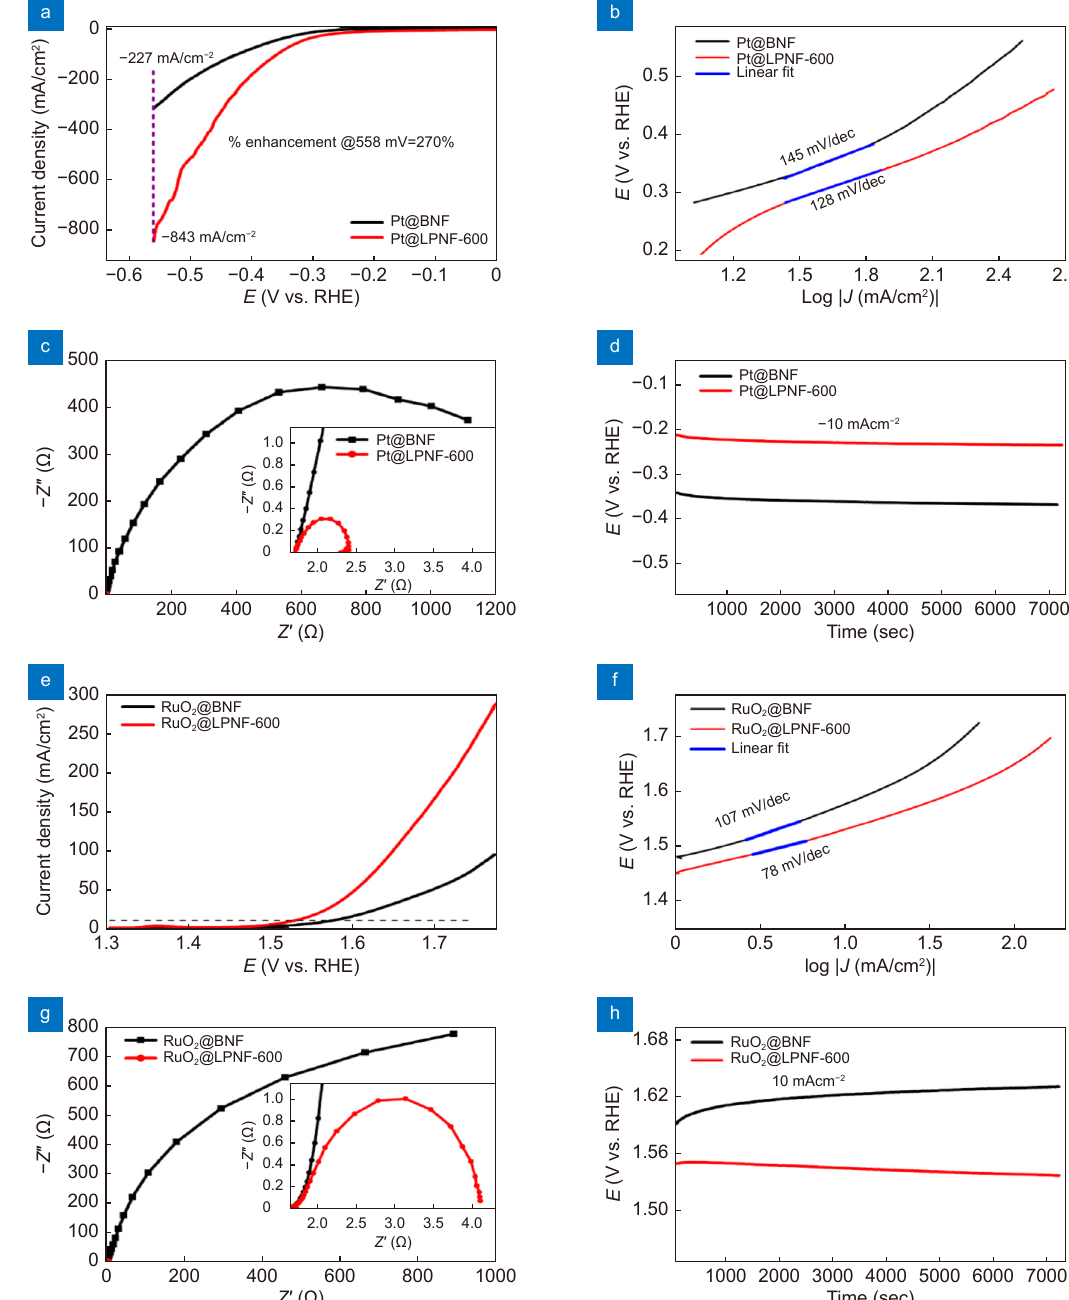
Fig. 6 | Demonstration of LEFIRC effect induced reduction in the electrochemical fuel generation potential when the LPNF-600 sample is used as a cathode or an anode substrate to support Pt/C or RuO 2 electrocatalyst . ( a – d ) HER and ( e – h ) OER measurements for Pt/C and RuO 2 inks loaded on BNF and LPNF-600 substrates in 1.0 M KOH solution at room an OER electrocatalyst in an alkaline electrolyte (Fig. drive 10 mA/cm 2 of current density. At an overpotential 6(e–h)). The LSV curves for the BNF and LPNF-600 sub- of 750 mV, the oxygen generation performance of the strates, loaded with 0.25 mg/cm 2 of RuO 2 electrocata- LIPSS patterned substrate is enhanced by 211% over the lysts powder, demonstrate that the LEFIRC effect re- bare substrate (Fig. S20(a)). The Tafel slope for the duces the η 10 overpotentials from 400 mV (BNF) to 300 LPNF-600 substrate (78 mV/dec) is 27.1% lower as com- mV (LPNF-600) resulting in a 25% reduction in the re- pared to the BNF (107 mV/dec) substrate (Fig. 6(f)). The quired electrical power (Fig. 6(e) and Fig. S19(b)) to enhanced performance of the LPNF-600 substrates is